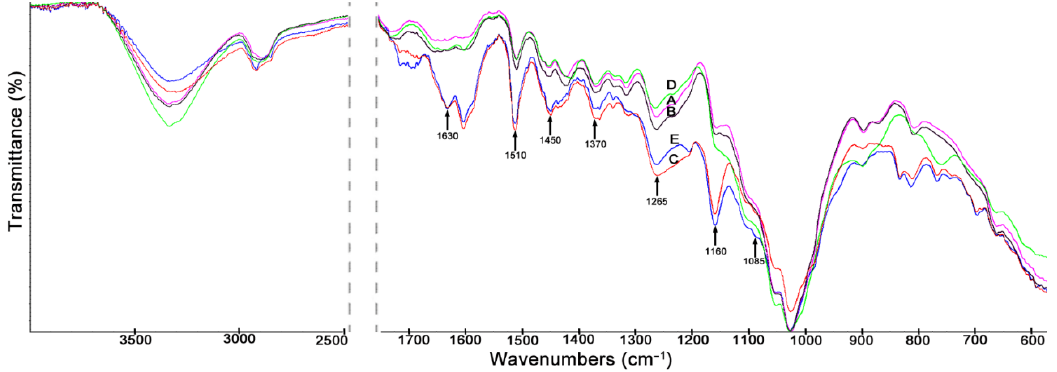
Figure 2. The ATR-FTIR spectra of Scots pine wood (A), wood treated with 70% EtOH (B), wood treated with EEP (C), wood treated with MPTMOS-TEOS (D), and wood treated with EEP-MPTMOS/TEOS